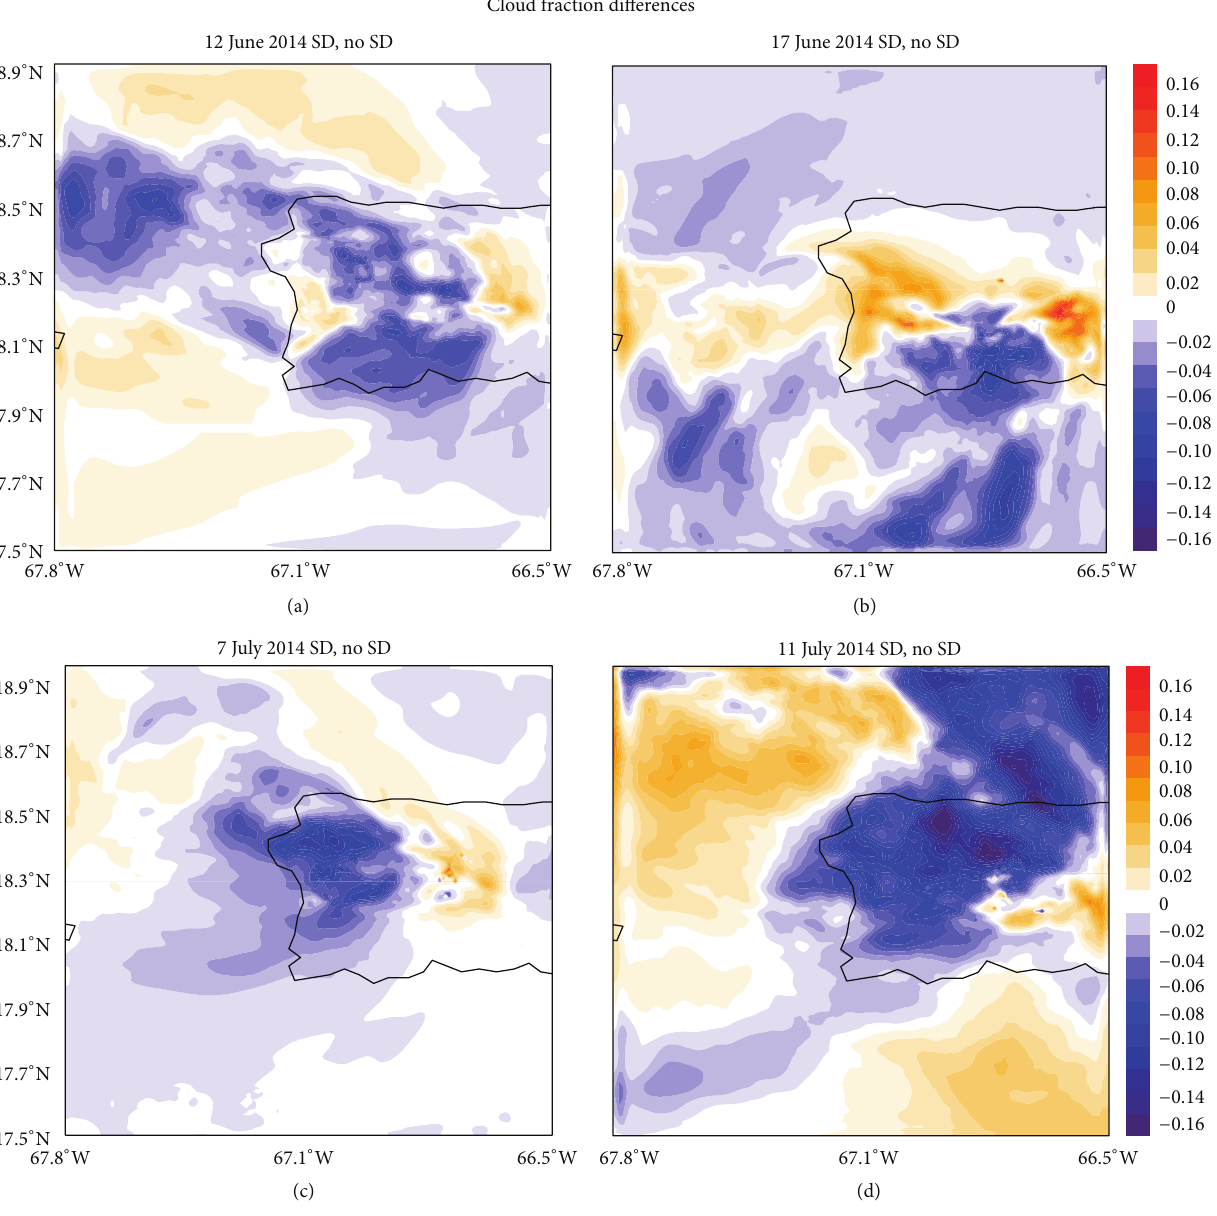
Figure 10: RAMS generated cloud fraction differences between SD and no SD runs for 12 June 2014 (a), 17 June 2014 (b), 7 July 2014 (c), and 11 July 2014